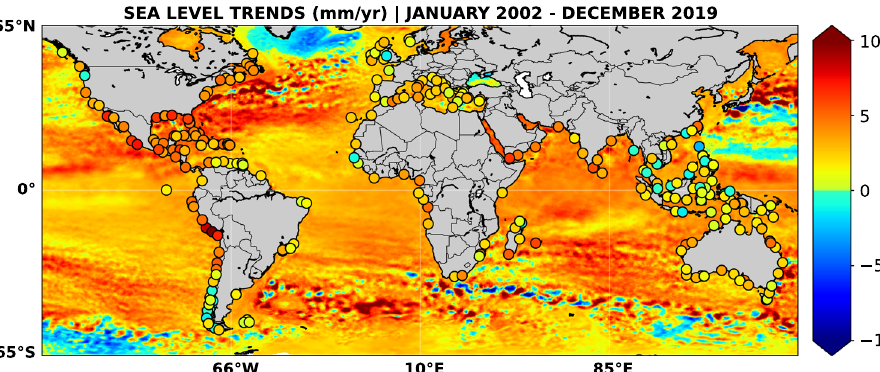
Fig. 5 Coastal and regional sea level trends (mm/yr) over the 18-yr time span. Coastal trends at virtual stations closer than 3.5 km from the coast are indicated by the black circles. The background map shows regional sea level trends from the C3S data set.